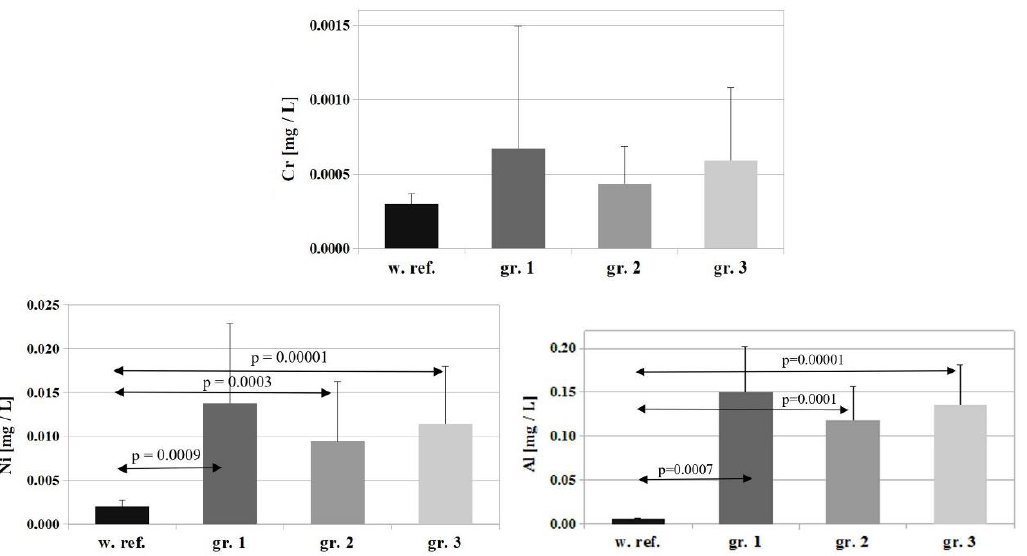
Figure 3. Comparison of reference values for Cr and permissible serum limit for Ni and Al and their concentrations in the serum of patients on the first day of hospitalization. w.ref. – reference value; gr – group